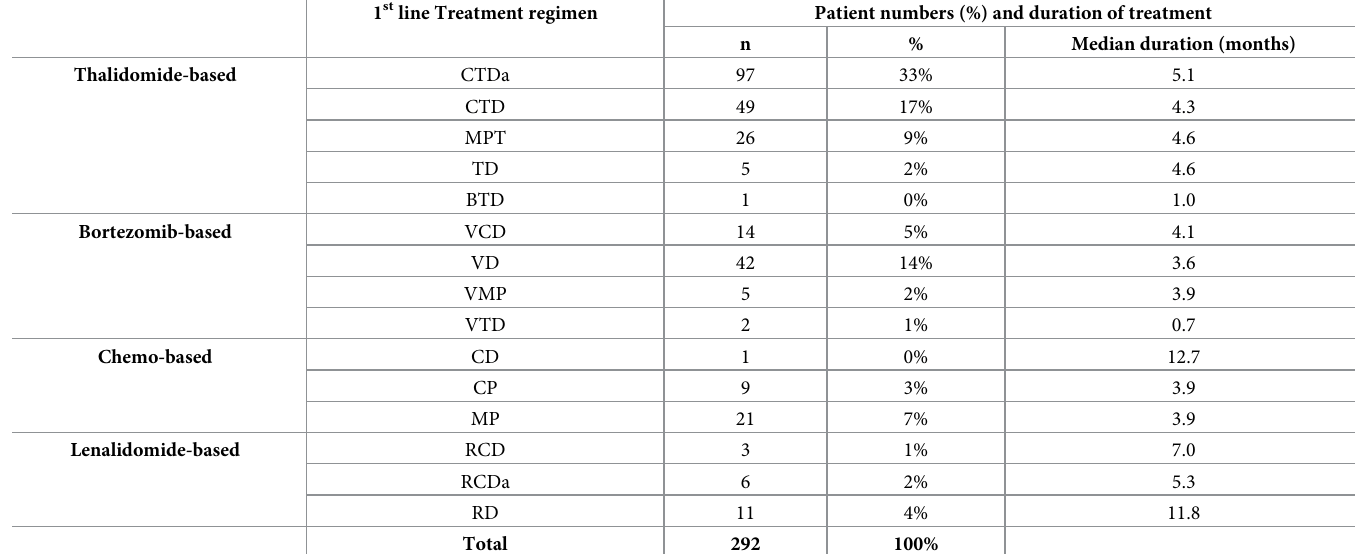
Table 3. Chemotherapy regimen used as first line therapy.